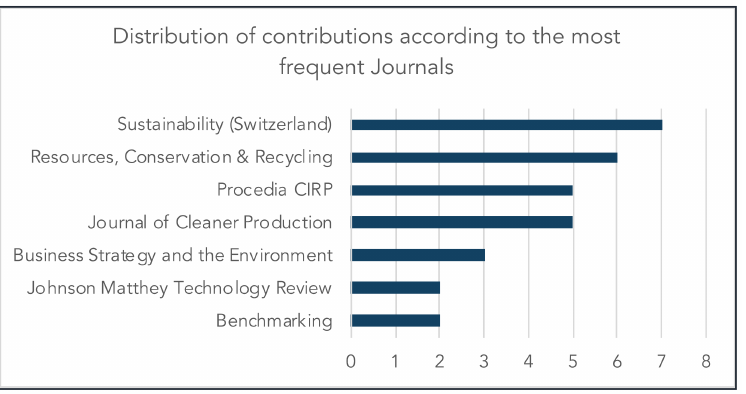
Figure 5. Distribution of the reviewed contributions according to the most frequent